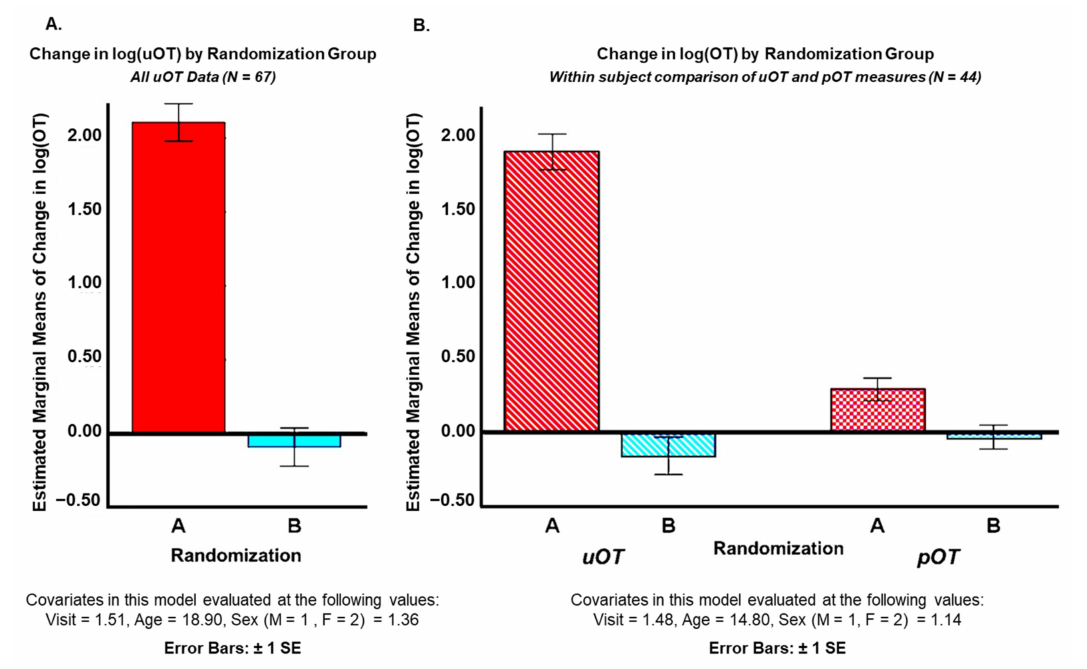
Figure 2. Mean differences between pre- and post-intranasal drug administration levels of ( A ) urine oxytocin (uOT) across all participants (ASD, AN, HC) and ( B ) mean differences between pre- and post-intranasal drug administration levels of uOT and plasma oxytocin (pOT) for ASD participants only. Analyses were conducted blind to which group (Randomization Group A or B) received active drug versus placebo at each time-point.